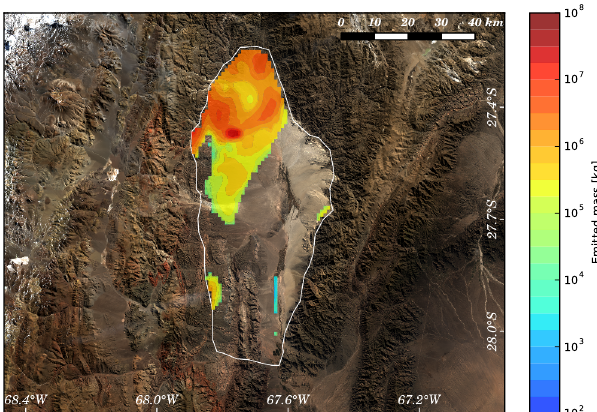
Figure 10. Grid emitted mass throughout the 54h simulation ac- cording to the Shao emission scheme using meteorological data from the innermost domain d03 (2km). We assume that dust emis- sion takes place only within the spatial region defined by the solid white line delimiting the Fiambalá Basin. In the background, a Landsat-8 image acquired on 14 June